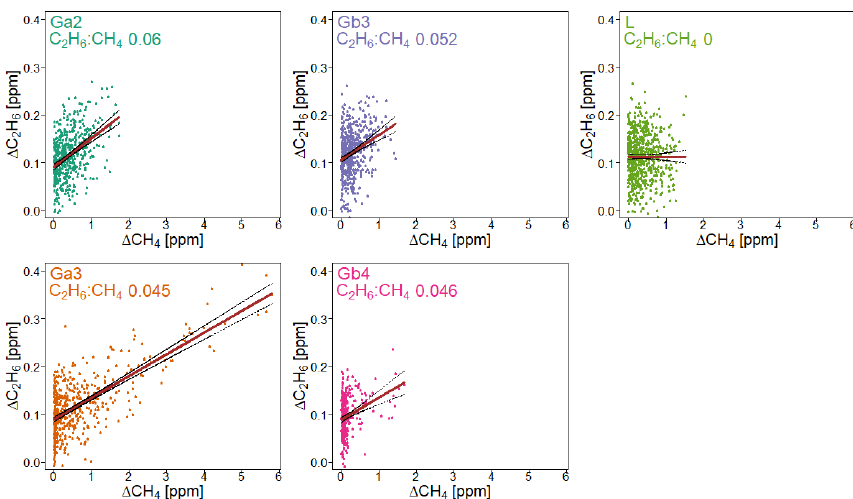
Figure 7. Fieldwork. C 2 H 6 : CH 4 for gas compressor stations (Ga and Gb) and the landfill (L), calculated for non-averaged data. Linear fitting (red line) with confidence intervals (black lines).